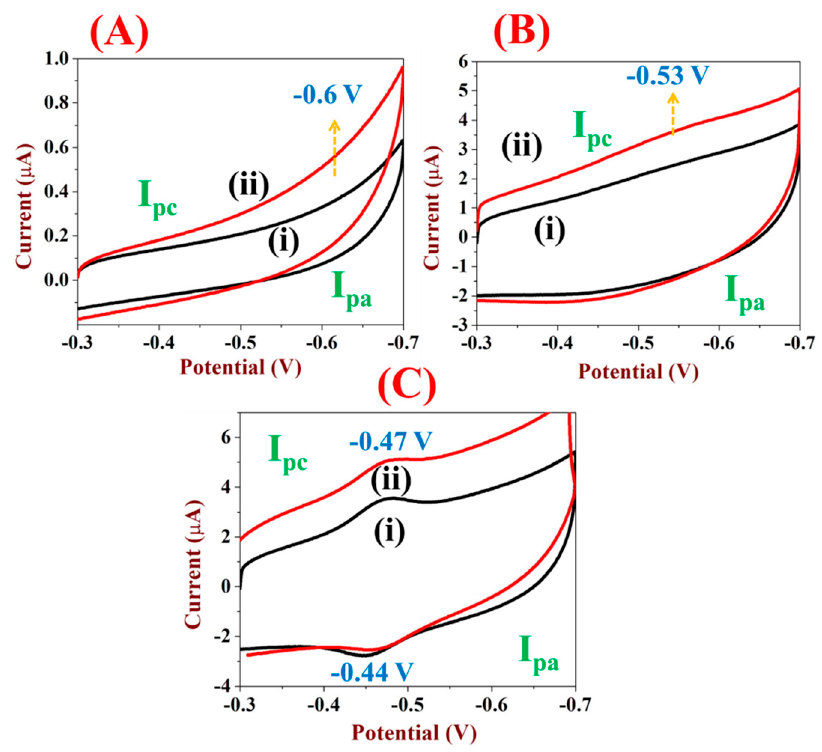
Figure 2. CVs were recorded using ( A ) bare GCE, ( B ) Ti 3 C 2 T x /GCE, and ( C ) FAD/Ti 3 C 2 T x /GCE in 0.1 PBS without (curves i) and with 100 nM H 2 O 2 (curves ii) in 0.1 M PBS, scan rate = 50 mV/s.